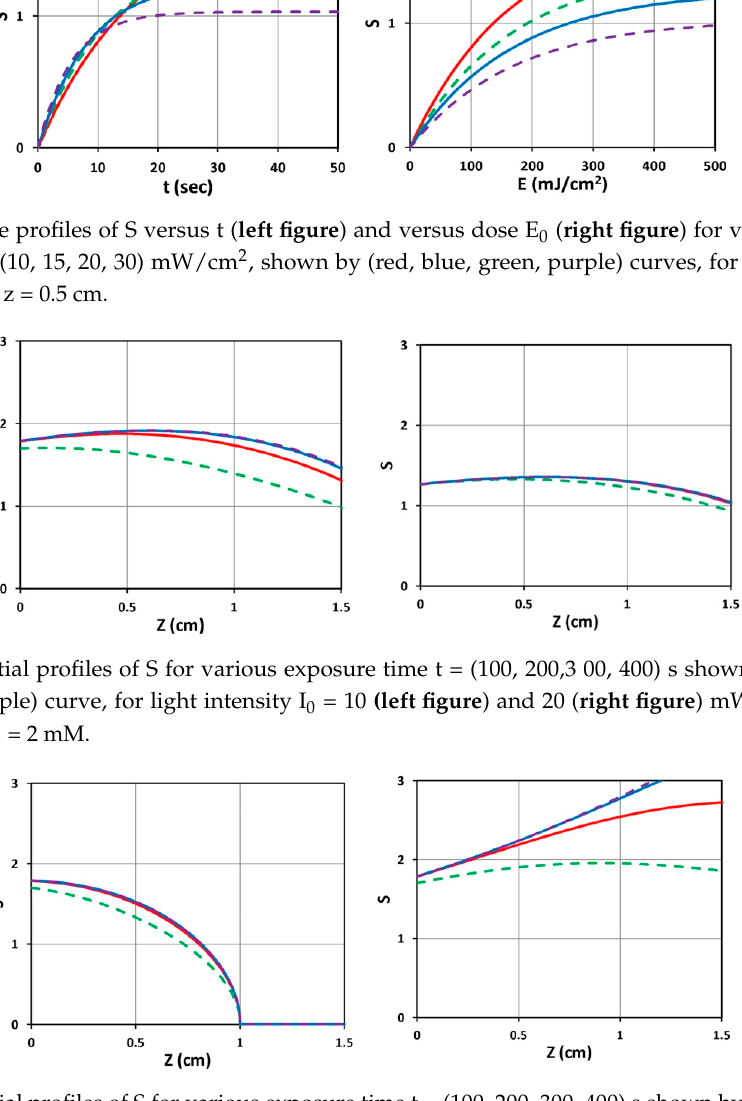
Figure 6. Steady-state S versus PI concentration (C 0 ), for z = 0 ( left figure ) and z = 0.5 cm ( right figure ), for D = 1.0 cm, I 0 = 10 mW/cm 2 . Figure 7. S versus light intensity (I 0 ), for t = 100 s (red curve) and 200 s (green curve), and z = 0.5 cm, D = 1.0 cm, C 0 = 2 mM.